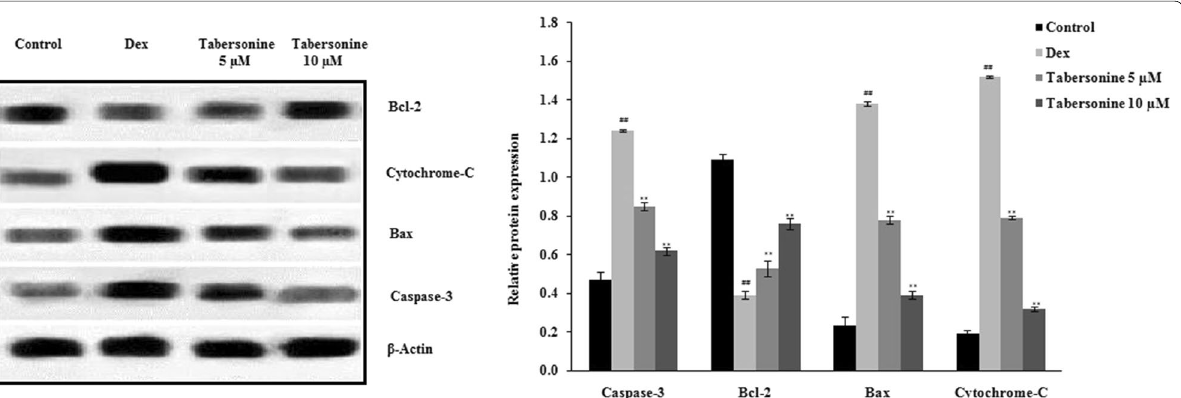
SEMs ( n 10). ## p < 0.01 vs. control, ± =